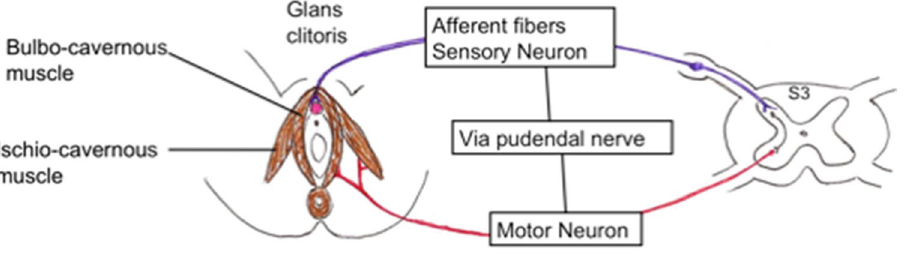
Figure 1. Schematic illustration of the clitoro-perineal